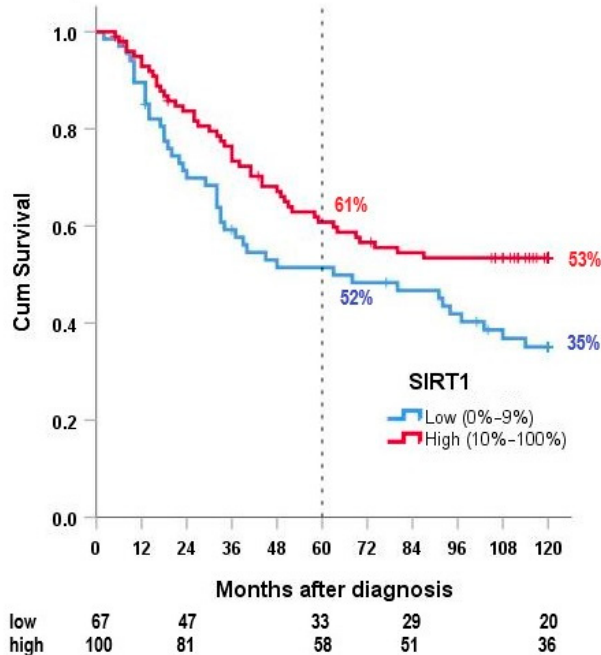
Figure 4. Overall survival according to SIRT1 expression.